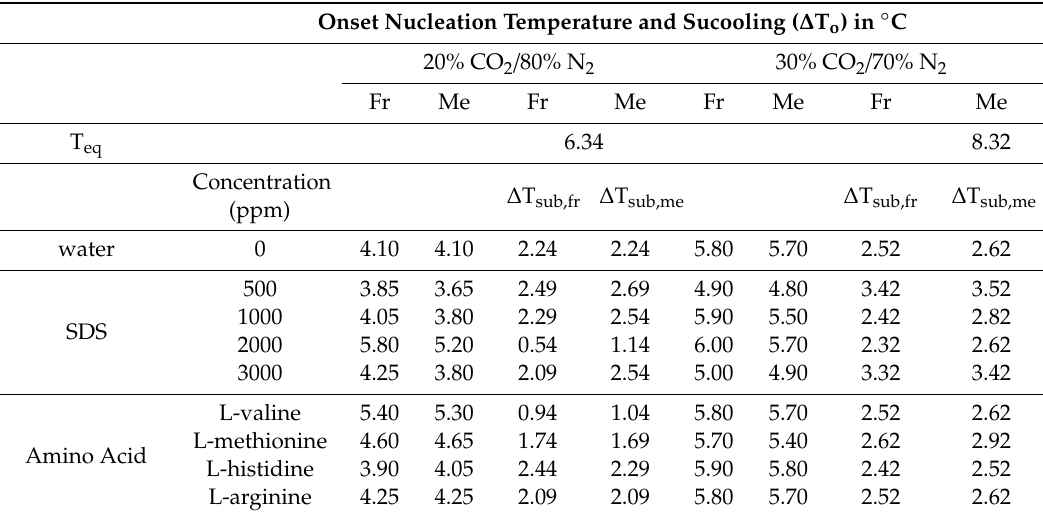
Table 5. E ff ect of change in CO 2 concentration on onset temperature (To) during fresh (Fr) and memory (Me) run for 10 mL solution at initial pressure 120 bar in constant ramping temperature scheme. Onset Nucleation Temperature and Sucooling ( ∆ T o ) in ◦ C 20% CO 2 / 80% N 2 30% CO 2 / 70% N 2 Fr Me Fr